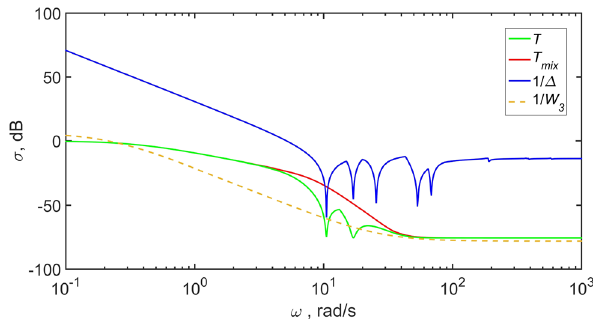
Figure 13: Robust stability test.